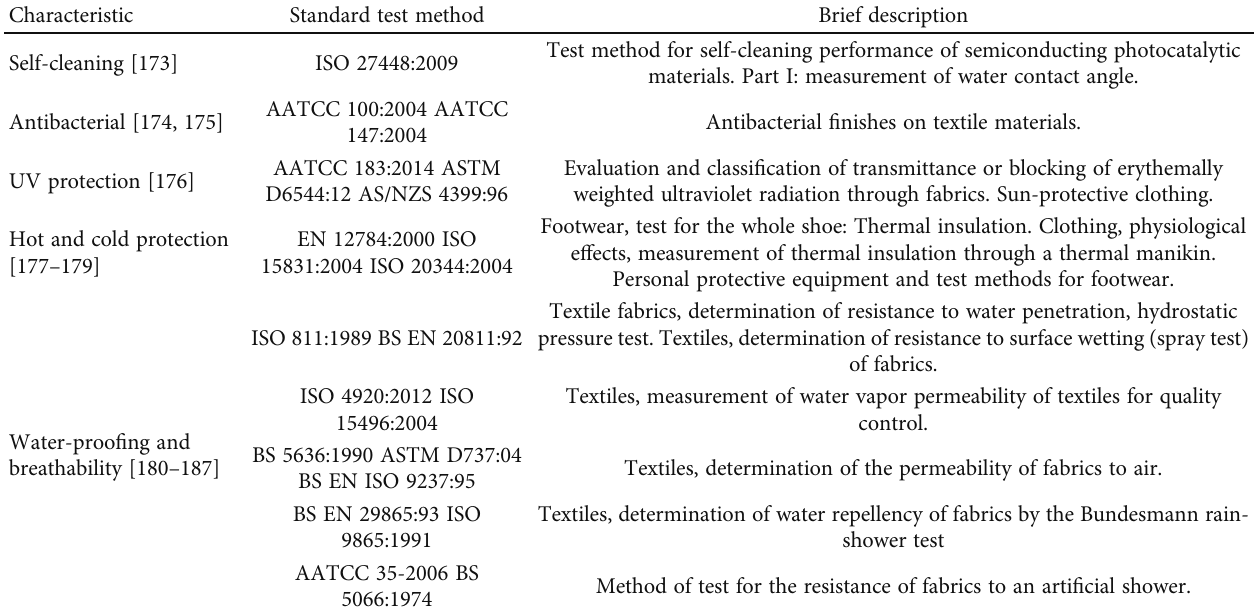
Table 6: Test methods for sportswear properties ’